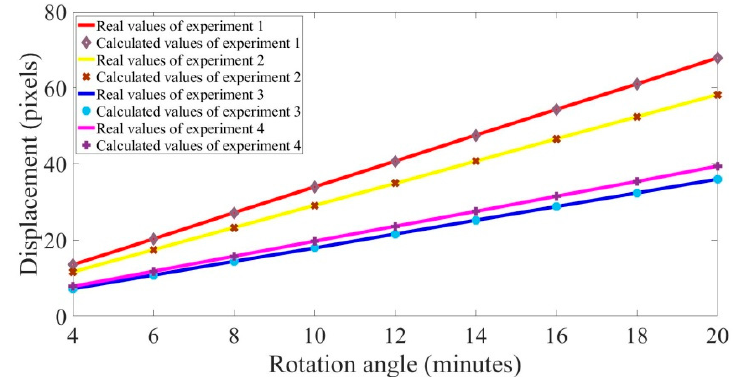
Figure 17. Comparison of displacement results at different rotation angles.